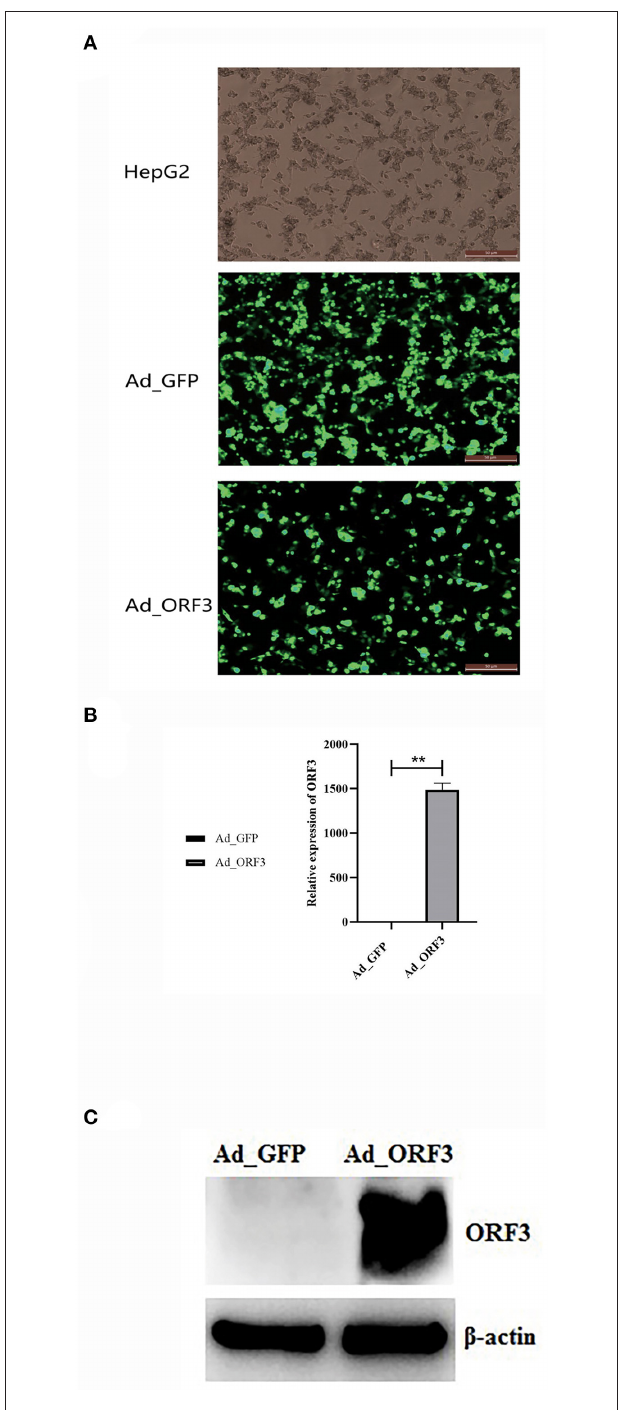
FIGURE 1 | Adenovirus of ADV4-ORF3 and ADV4-NC mediated overexpression of ORF3 in HepG2 cells. (A) Fluorescence microscope observation of HepG2 cells infected by adenovirus of ADV4-ORF3 and ADV4-NC for 24h. (B) qRT-PCR validation for the relative expression level of ORF3. (C) Western blot analysis of HepG2 cells infected by adenovirus of ADV4-ORF3 and ADV4-NC for 24h with rabbit polyclonal antibody against ORF3. β -Actin was used as an internal control. * p < 0.05, ** p <